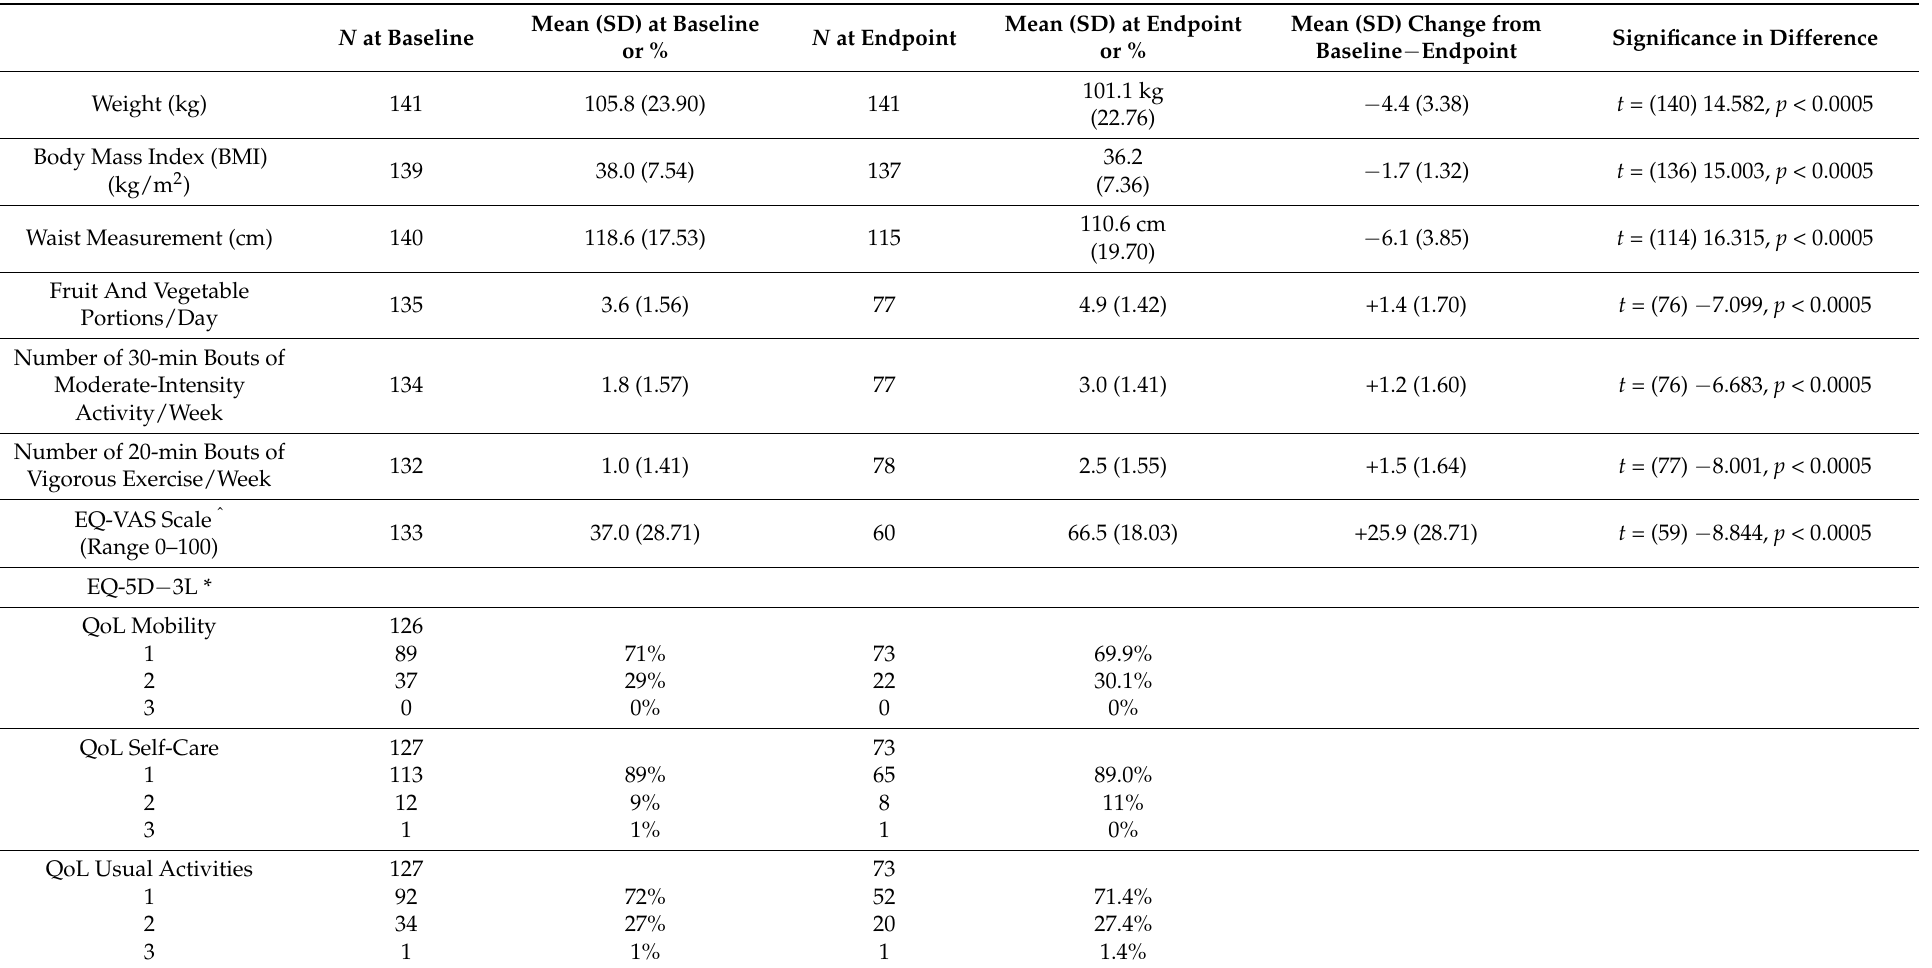
Table 2. Anthropometric and behavioural and psychological measures: baseline, endpoint, and change